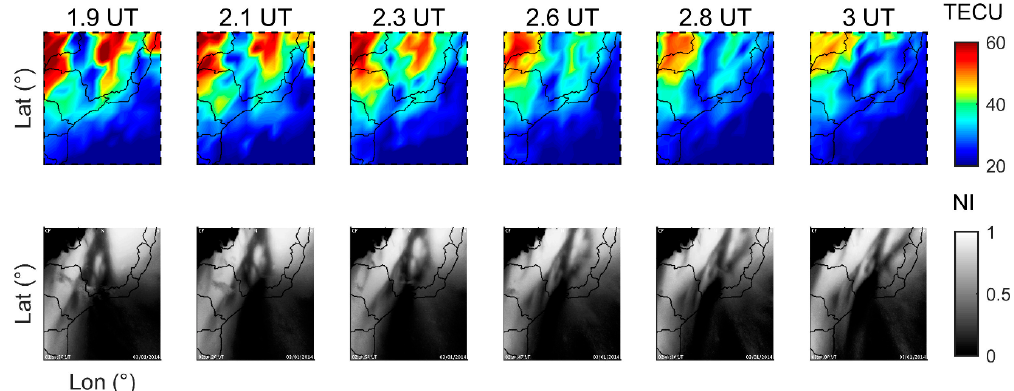
Figure 4. Example of a plasma bubble propagating through Cachoeira Paulista (CHPI) in DOY 3 of 2014 detected by the VTEC reconstructions and the optical instruments.